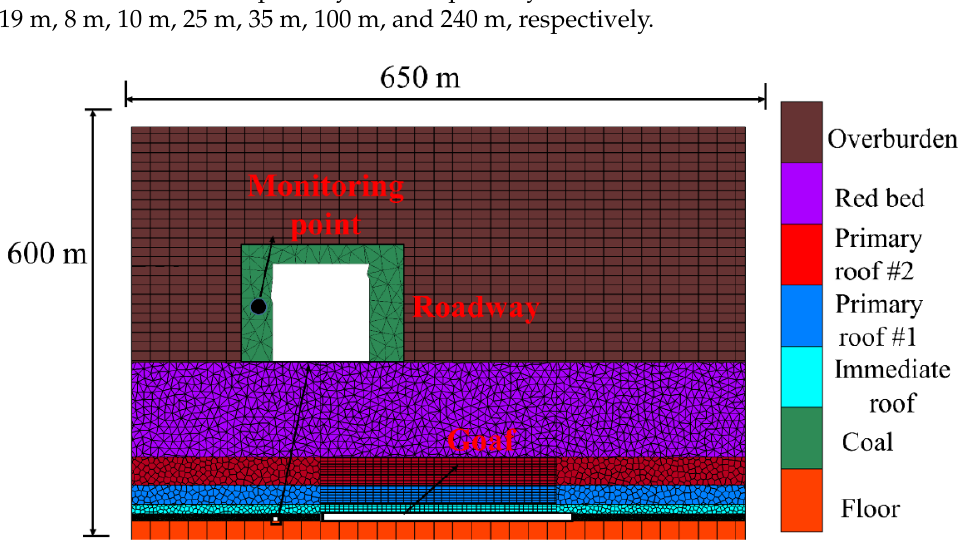
Figure 1. Numerical model.